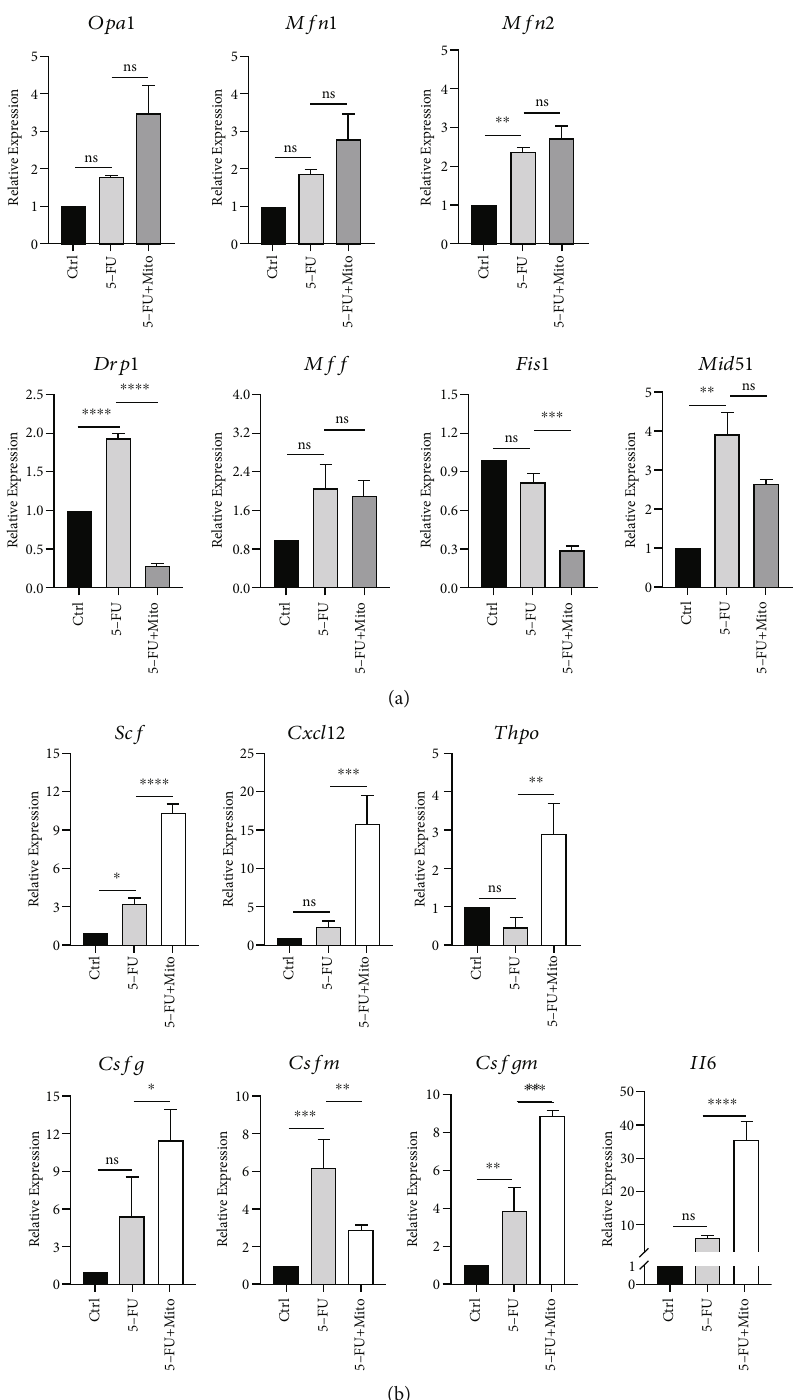
Figure 7: Analysis of mRNA expression of hematopoietic regulatory factor genes and mitochondrial fusion/ fi ssion genes in BA-MSCs after mitochondrial treatment of BA-MSCs damaged by 5-FU. (a) Gene expressions of Opa1 , Mfn1 , Mfn2 , Drp1 , M ff , Fis1 , and Mid51 in DMSO- treated BA-MSCs, 5-FU-treated BA-MSCs, and mitochondria-treated 5-FU-damaged BA-MSCs were detected by qRT-PCR ( n = 3 ). (b) Gene expressions of Scf , Cxcl12 , Thpo , Csfg , Csfm , Csfgm , and Il6 in DMSO-treated BA-MSCs, 5-FU-treated BA-MSCs, and mitochondria-treated 5-FU-damaged BA-MSCs were detected by qRT-PCR ( n = 3 ). All data are presented as mean ± SEM . Statistics: one-way ANOVA (ns: not signi fi cant; ∗ p < 0 : 05 , ∗∗ p < 0 : 01 , ∗∗∗ p < 0 : 001 , and ∗∗∗∗ p < 0 : 0001